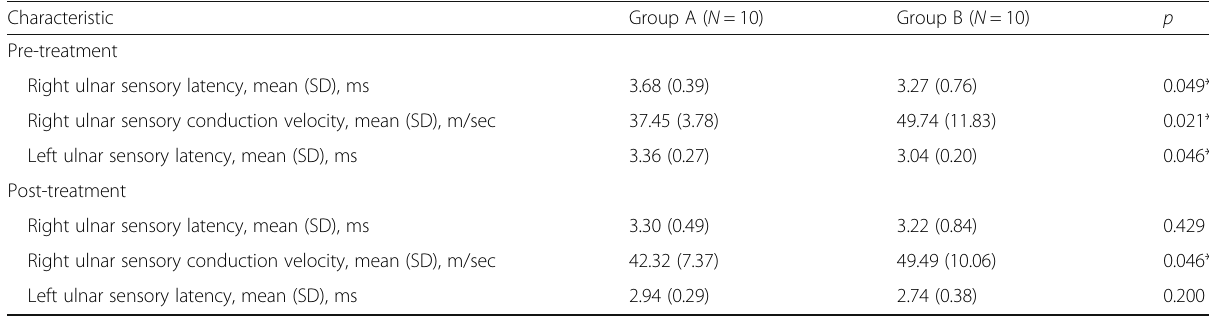
Table 2 Cohort comparisons for nerve conduction parameters Characteristic Group A ( N = 10) Group B ( N = 10) p Pre-treatment Right ulnar sensory latency, mean (SD), ms Right ulnar sensory conduction velocity, mean (SD), m/sec Left ulnar sensory latency, mean (SD), ms Post-treatment Right ulnar sensory latency, mean (SD),